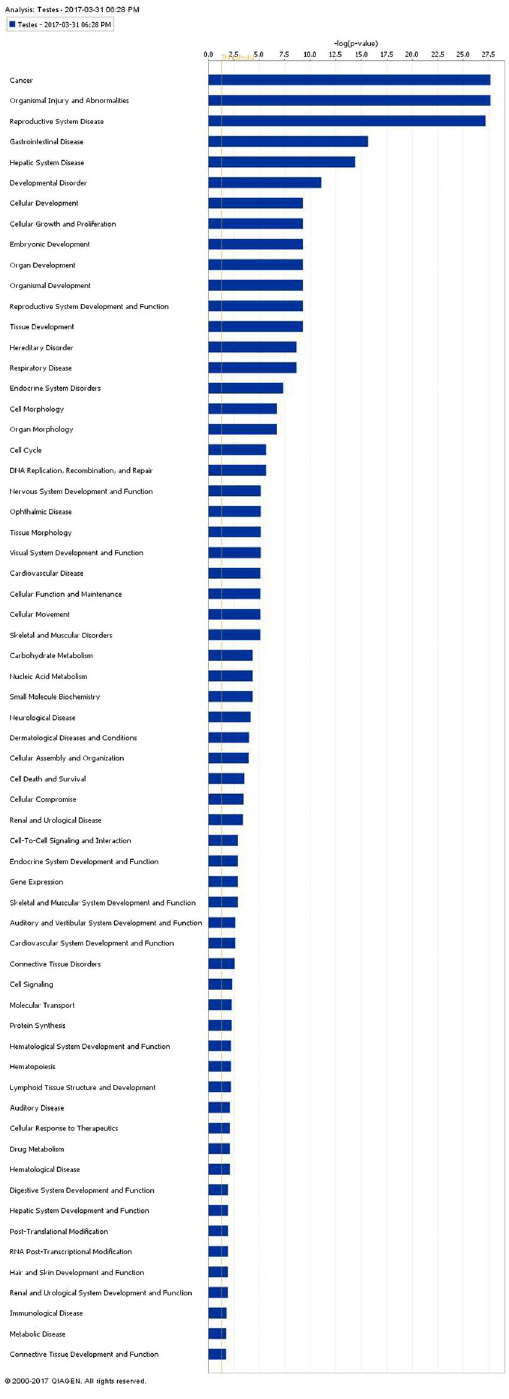
Figure 5. Molecular and cellular function of differentially expressed genes of the testes of Holstein-Friesian bull calves offered either a fed on low or a high plane of nutrition and and slaughtered at 18 weeks of age. The bars indicate the likelihood [ − log (P-value)] that the specific molecular and cellular function was affected by a high plane of nutrition. The threshold line in the bar chart represents a p-value of 0.05. Data were analyzed through the use of IPA (QIAGEN Inc., https://www.qiagenbioinformatics.com/products/ingenuitypathway- analysis) 51–54